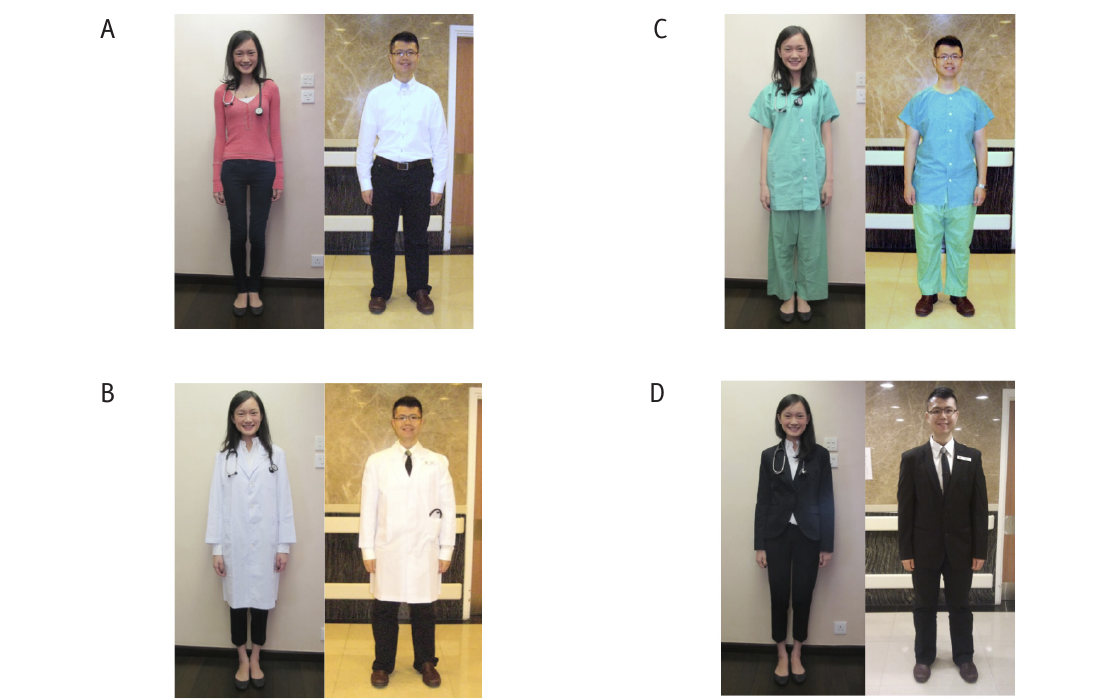
Figure 1. Female and Male Doctors Dressed in 4 Different Attires (A: Casual, B: Scrubs, C: White Coat and D: